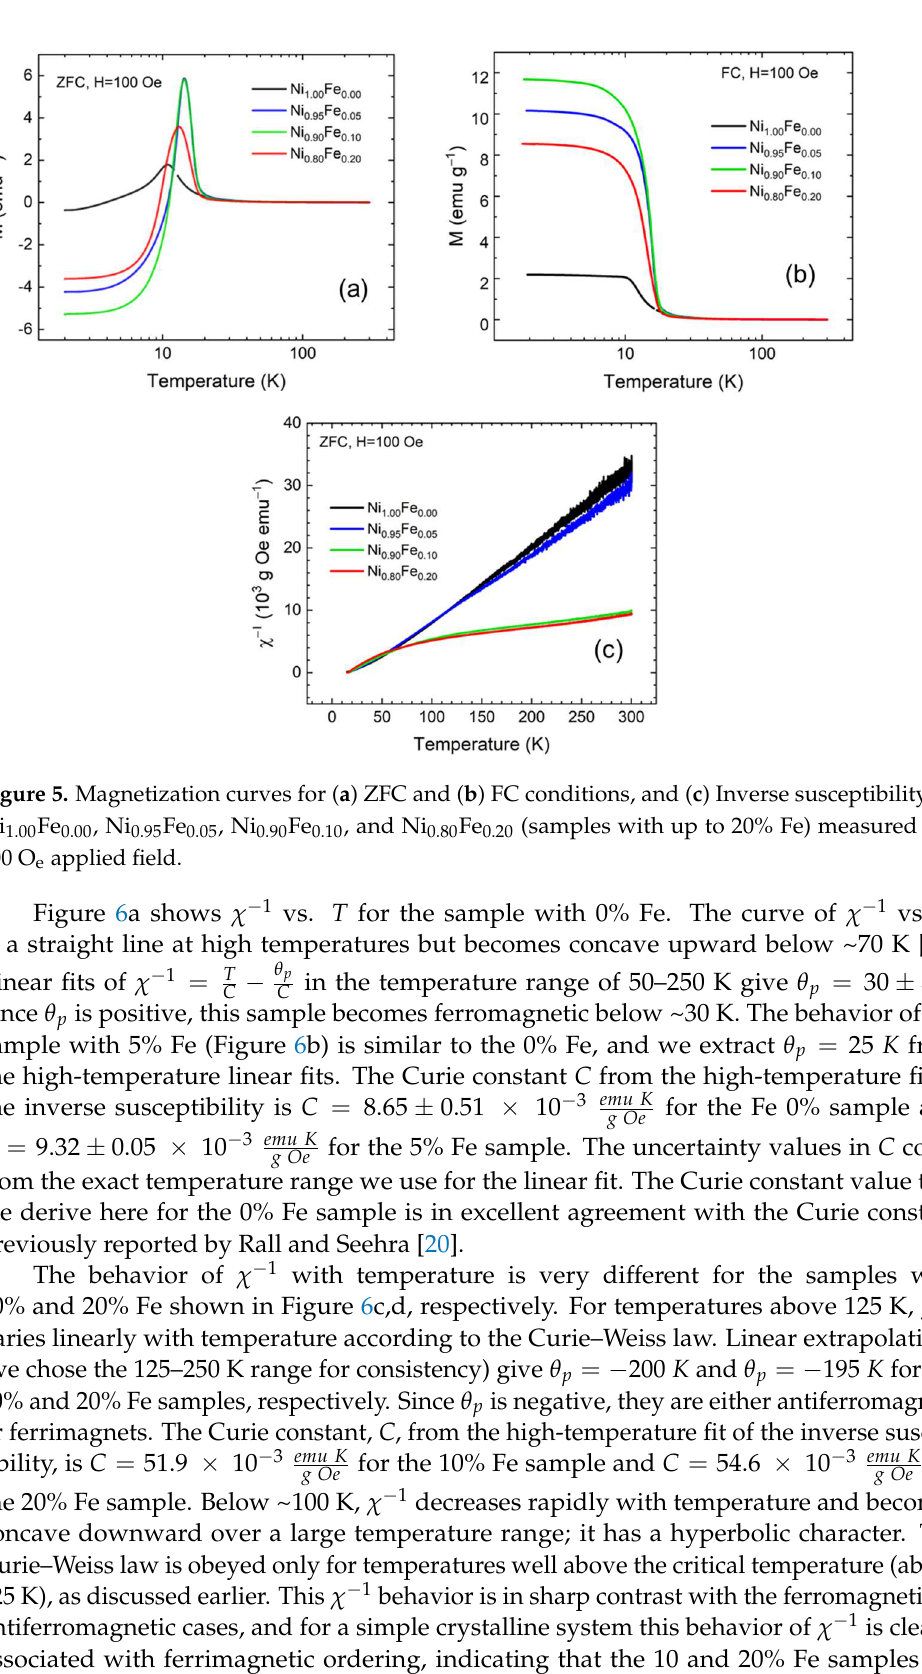
Figure 4. Bright-field transmission electron microscopy of Ni 1.00 Fe 0.00 ( a – c ) and Ni 0.95 Fe 0.05 ( d – f ) at different magnifications; the red box in Figure 4b denotes the region used for the higher magnifica- tion image shown in Figure 4c; yellow dotted circles in Figure 4c show crystalline domains with the (110) planes oriented perpendicular to the yellow arrows.